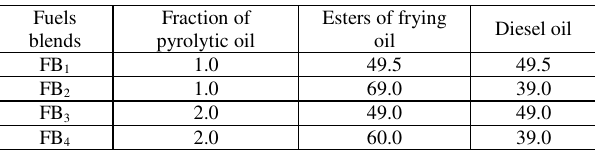
Table 3. Composition of the fuel blends (% v/v) Fuels blends